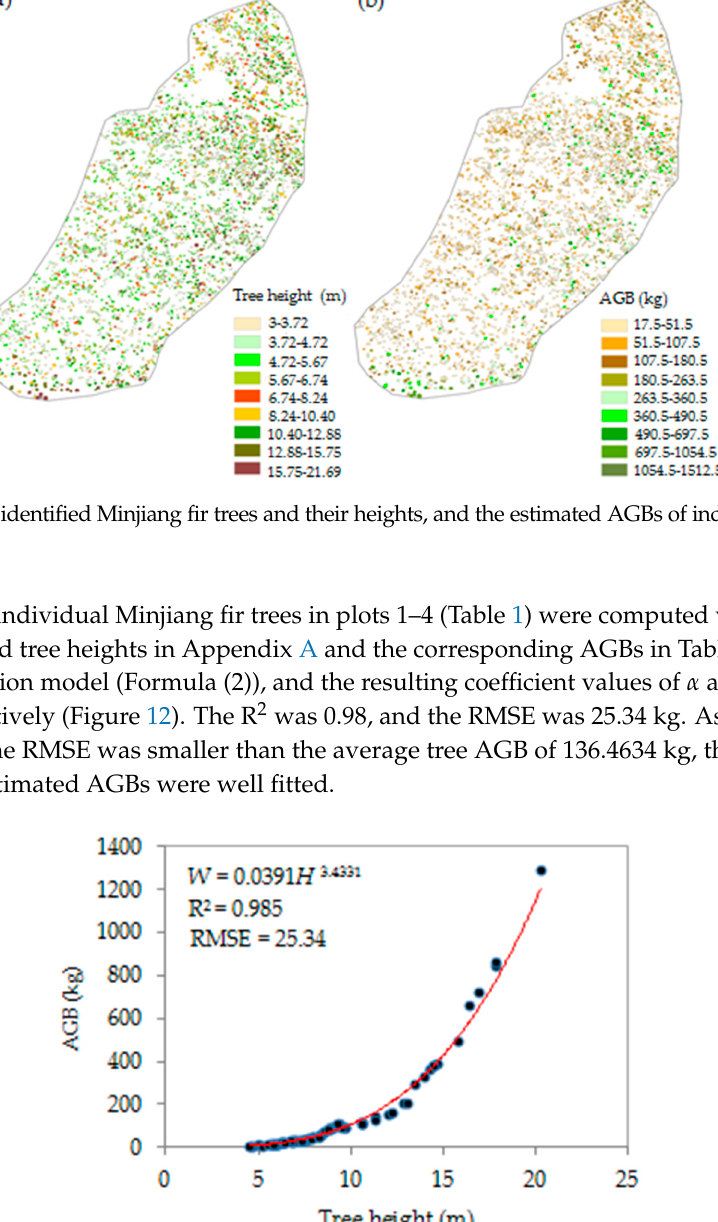
Figure 11. The identified Minjiang fir trees and their heights, and the estimated AGBs of individual trees.